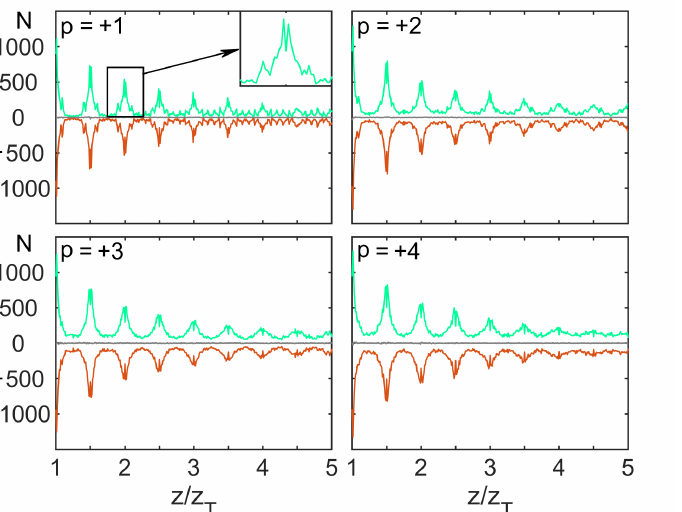
Figure 4. The quantity of positive (green) and negative (red) optical singularities N on the distance along the propagation axis z , calculated in the region 40 × 10 Λ 2